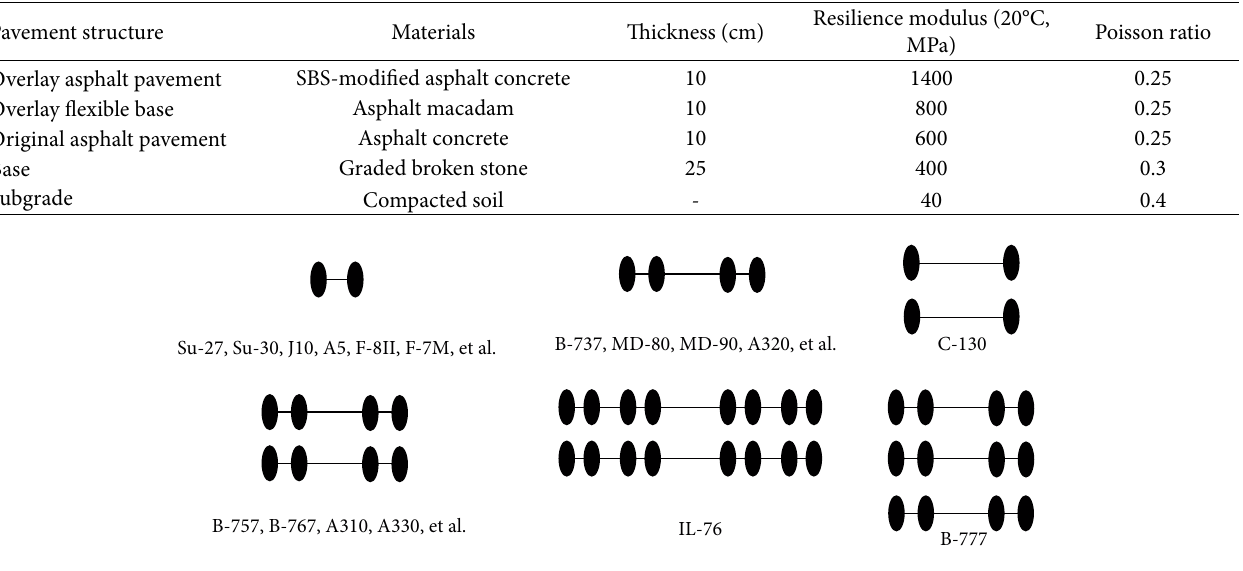
Figure 1: Common form of aircraft undercarriage. Table 2: Design parameters of B767 aircraft.